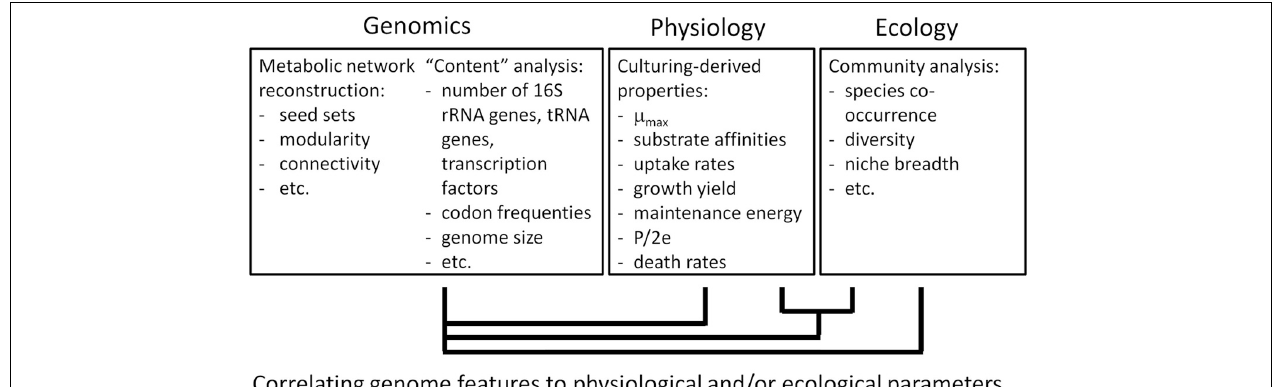
FIGURE 4 | From genome to physiology and ecology of a species. The interaction with their environment over evolutionary times has shaped the physiologyofmicroorganisms,whichiscontainedintheirgenomes.Weassume that,inreverse,thegenomeinformsonaspecies’physiologyandecology.This